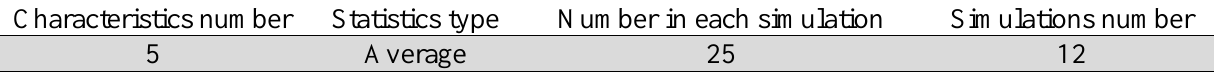
The characteristics of simulating Characteristics number Statistics type Number in each